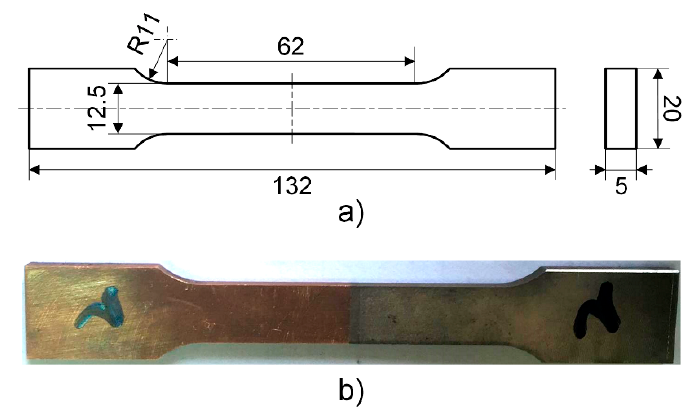
Figure 3. Tensile specimen ( a ) dimension (mm); and, ( b ) actual sample.